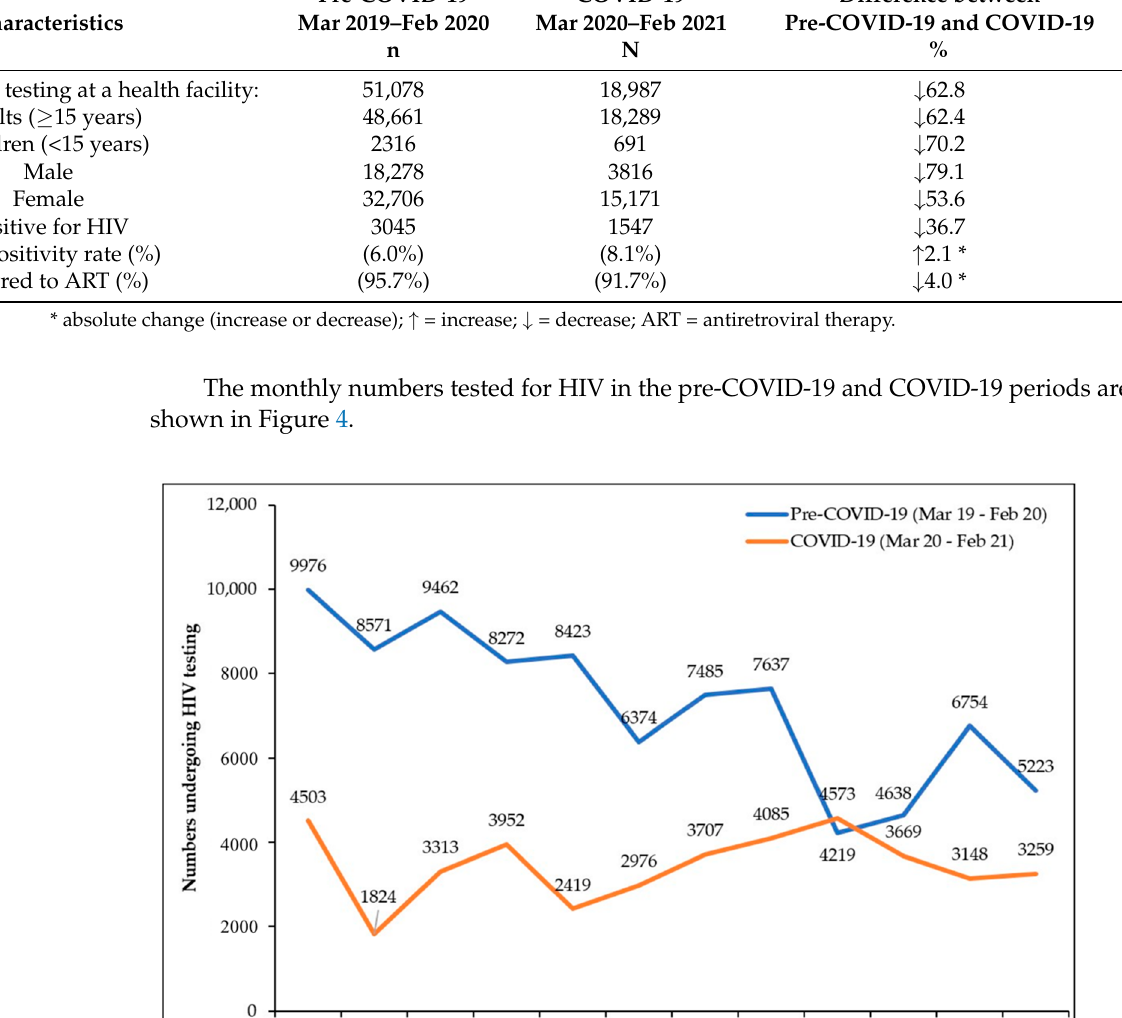
Table 3. Characteristics of persons tested for HIV and referred to antiretroviral therapy in 10 health facilities in Harare, Zimbabwe, during pre-COVID-19 and COVID-19 periods.